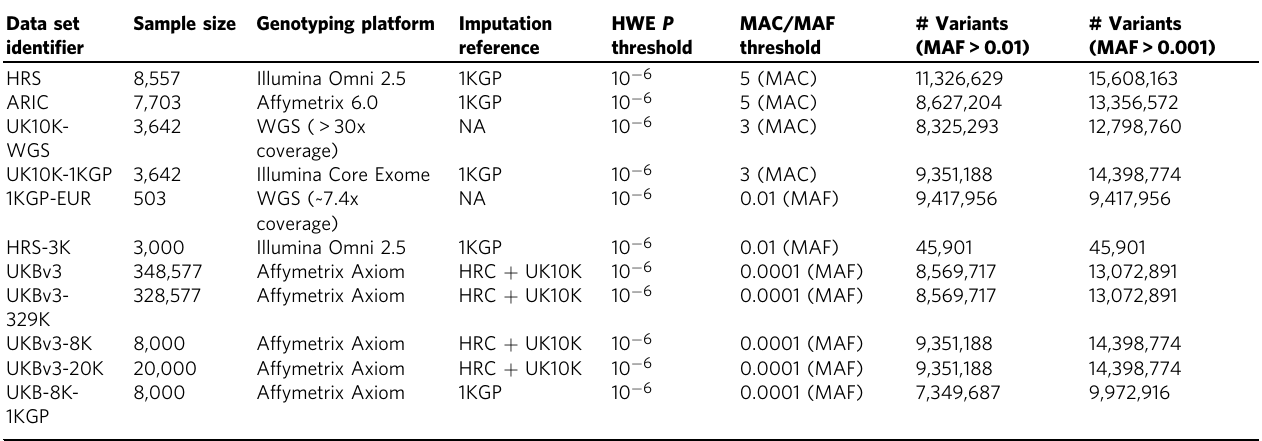
Table 1 A summary of the GWAS data sets with individual-level genotypes used in the present study. Data set identi fi